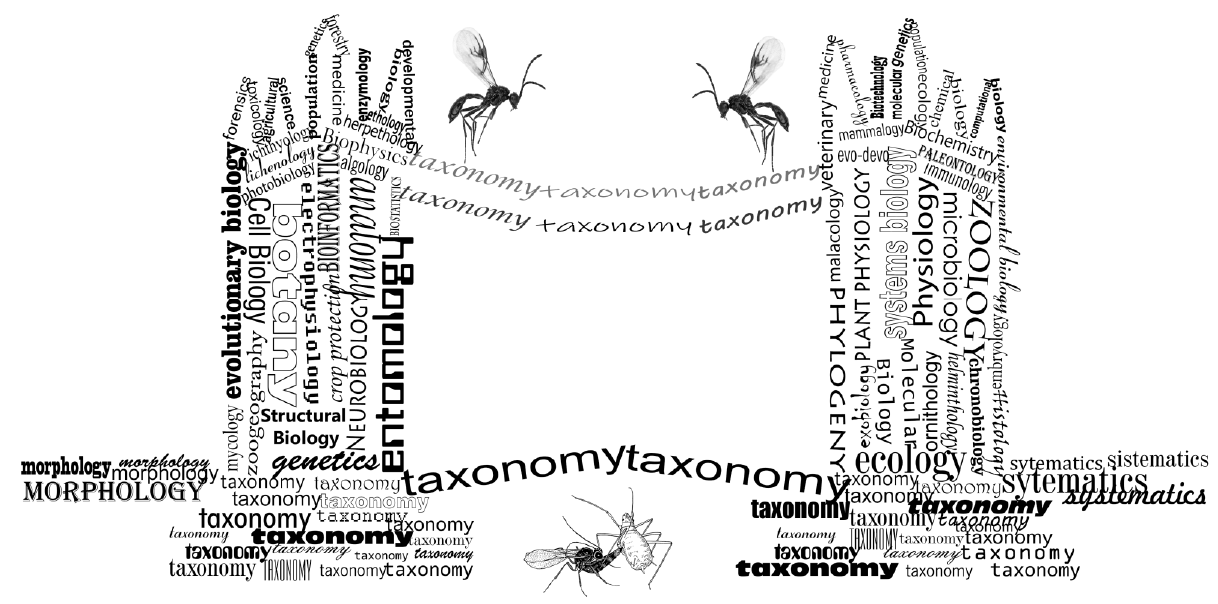
Figure 1. Position of taxonomy in biology today (inspired by words are bridge by mariateresa.dapolito).